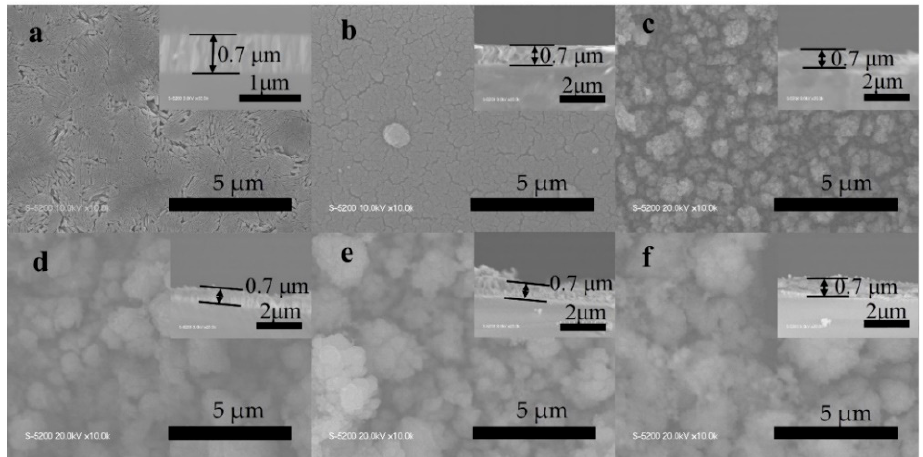
Figure 4. Scanning electron microscopy images of the surface view and cross-section of ( a ) pristine TiO 2 film and TiO 2 –Ag composite films deposited using different AgNO 3 concentrations: ( b – f ) 0.1, 0.5, 1, 2, and 4 wt%, respectively.